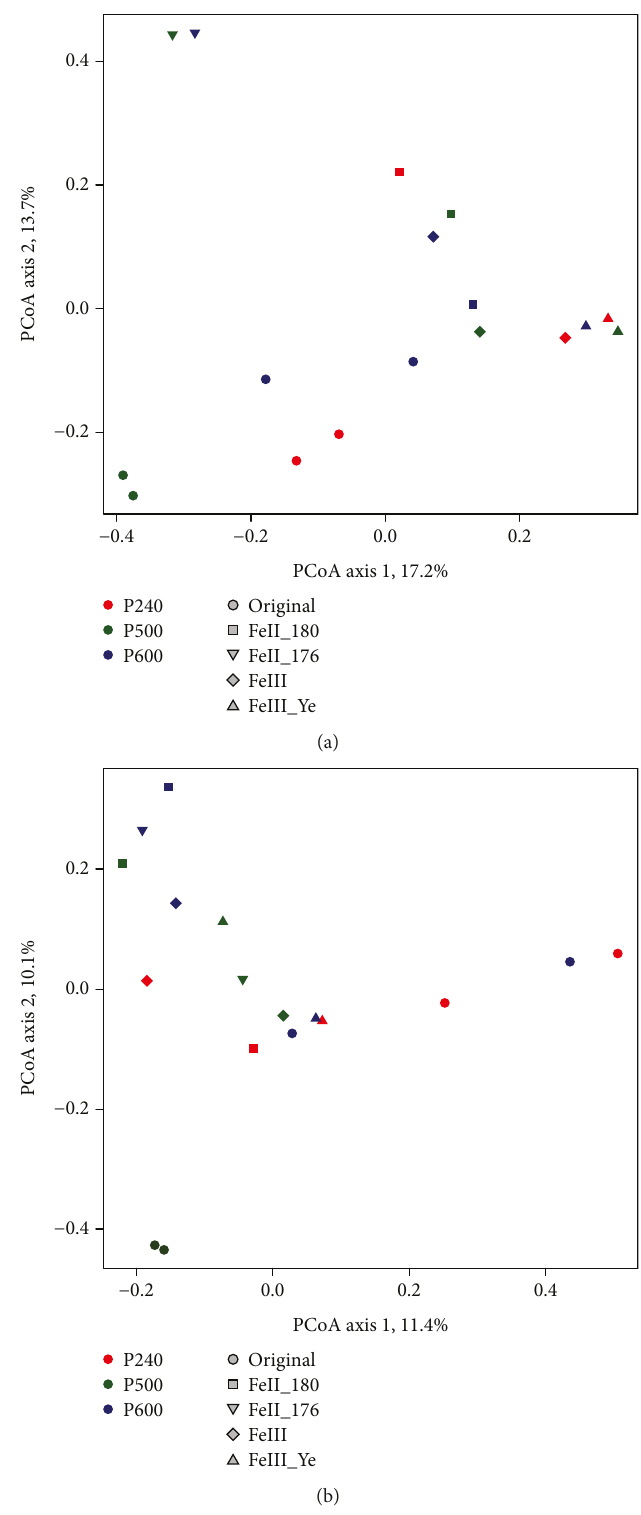
Figure 4: Principal coordinates analysis (PCoA) of the (a) bacterial and (b) fungal communities detected in the original mine water (circle) and enriched in medium 180 (square), medium 176 (downwards triangle), Fe(III) (diamond), and Fe(III)Ye (triangle). The colours indicate which mine water the sample originated from; red – P240m, green – P500m, and blue –